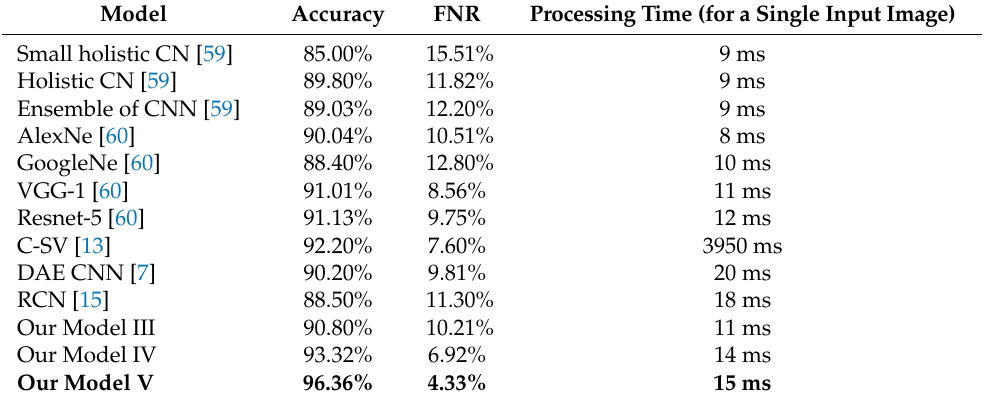
Table 3. Classification accuracy of our CNN model compared to other classifier models known from the relevant literature. A total of 160,000 samples were used, whereby 40,000 samples were used for validation and 40,000 samples were used for testing the